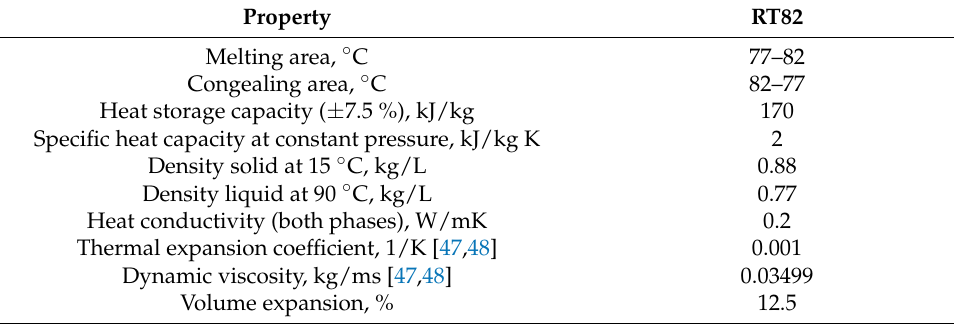
Table 2. Properties of PCM RT82.